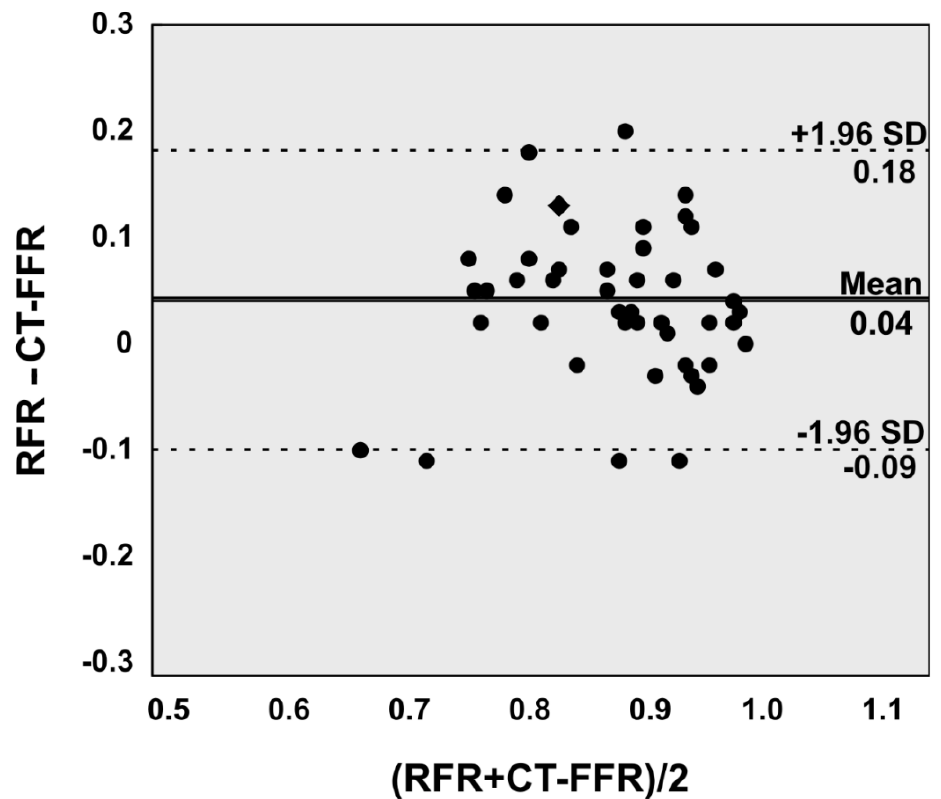
Figure 2. Bland-Altman plot illustrates good agreement between Resting full cycle ratio (RFR) and computed tomography angiography based fractional flow reserve (CT-FFR) on a per lesion level. Two assessments yielded identical values (Rhombus).